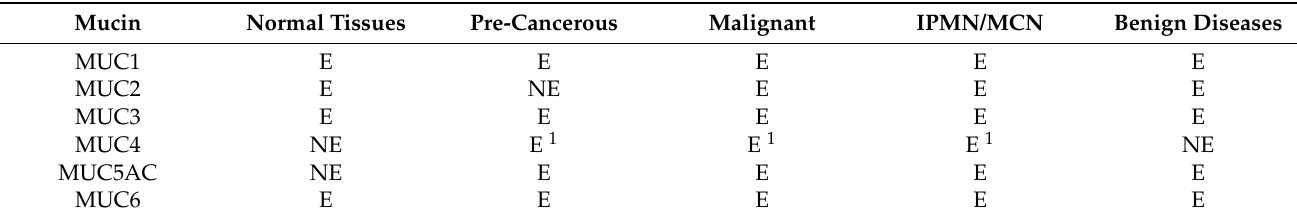
Table 1. Immunohistochemical expression of different mucins in pancreatic tissues [14,15]. Mucin Normal